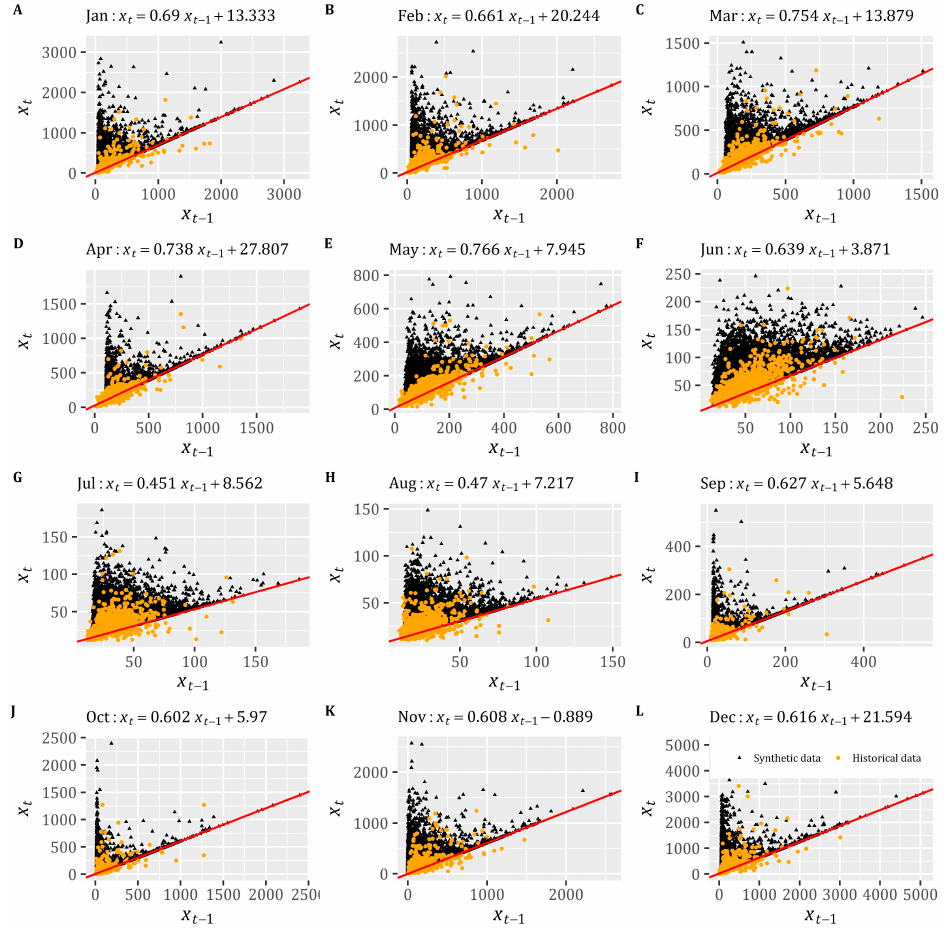
Figure 7. Scatter plots showing the lag-1 dependence pattern of the daily streamflow of the Achelous river at the Kremasta dam, Greece (orange dots; •) and of a synthetic time series generated using an AR(1)- P III model (black dots; • ). The red line (—) depicts the envelope equation embedded each plot.